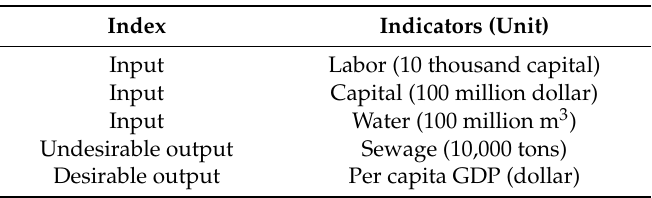
Table 1. Water use efficiency evaluation index